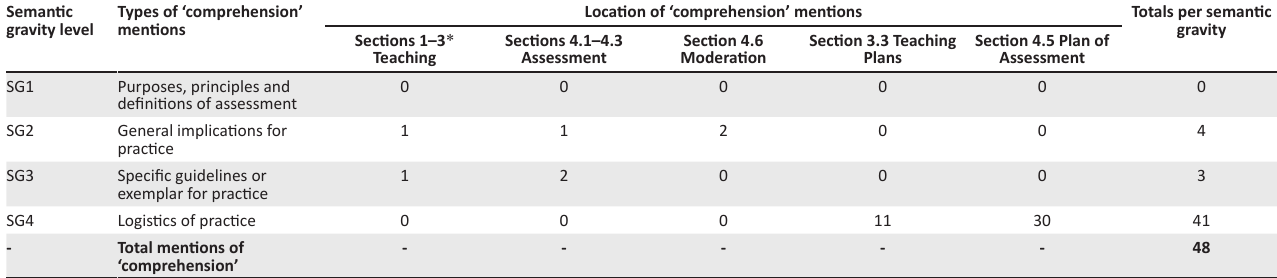
TABLE 4: Types of mentions of ‘comprehension’ in the Curriculum and Assessment Policy Statement document. Semantic Types of ‘comprehension’ gravity level